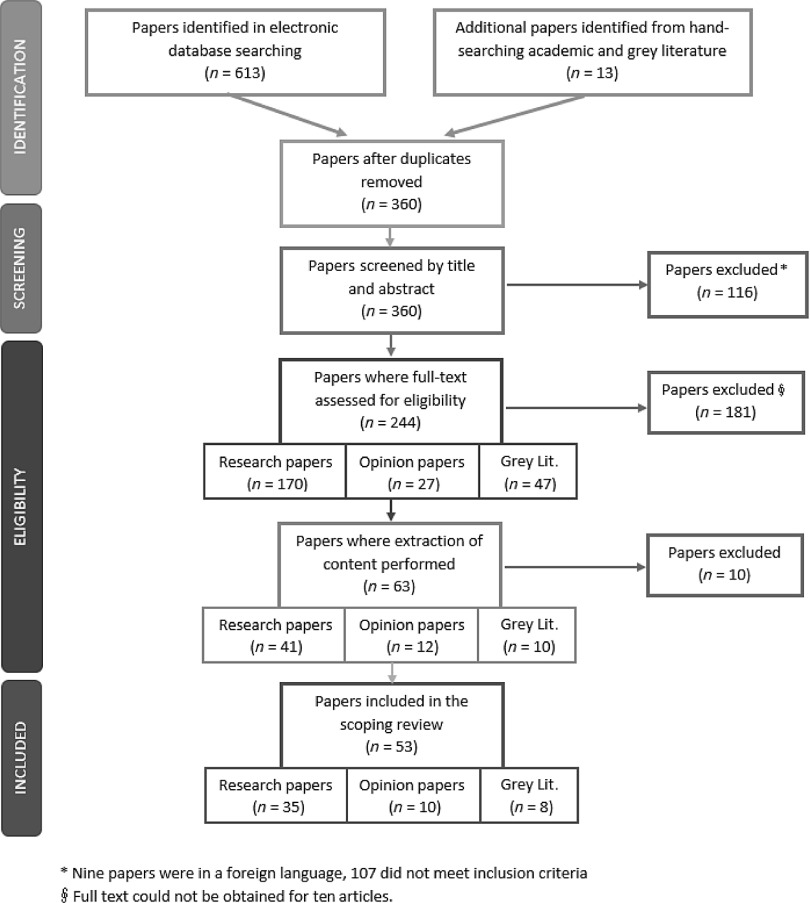
Screening flowchart